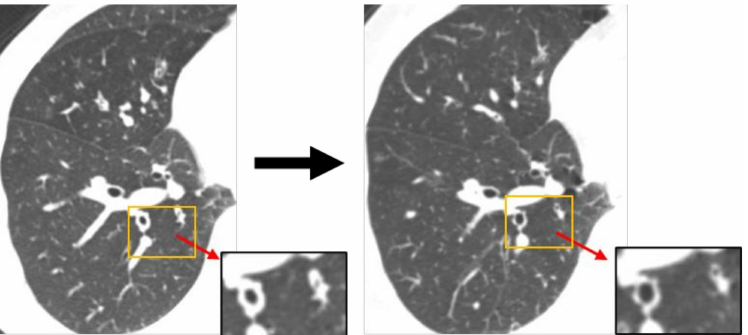
Figure 2. Chest CT before and one year after the start of